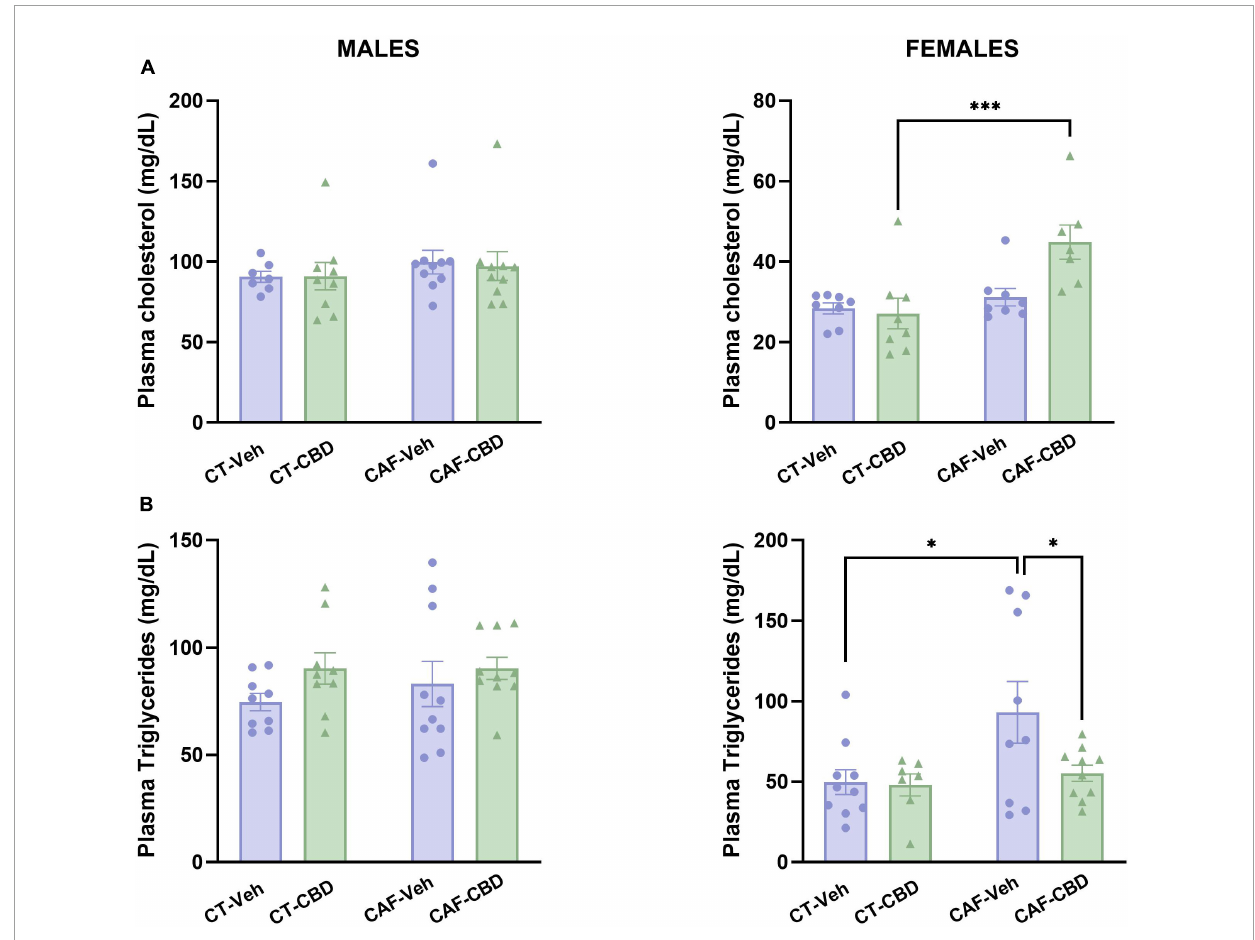
FIGURE4 Offspring’s plasma levels of total cholesterol and triglycerides. Female cafeteria diet (CAF)-cannabidiol (CBD) presented higher levels of plasma cholesterol than control diet (CT)-CBD (A) . Maternal diet increased triglyceride levels in females, but CBD treatment was able to revert this effect (B) . No differences were seen in males. Data are presented as mean ± SEM. n = 8–10/group. ∗ p < 0.05 ∗∗∗ p <